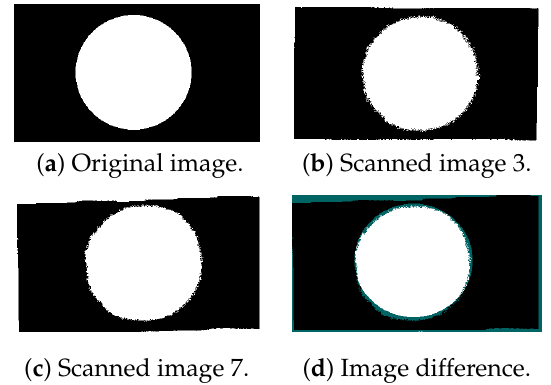
Figure 8. Appearance of the 7-scan process